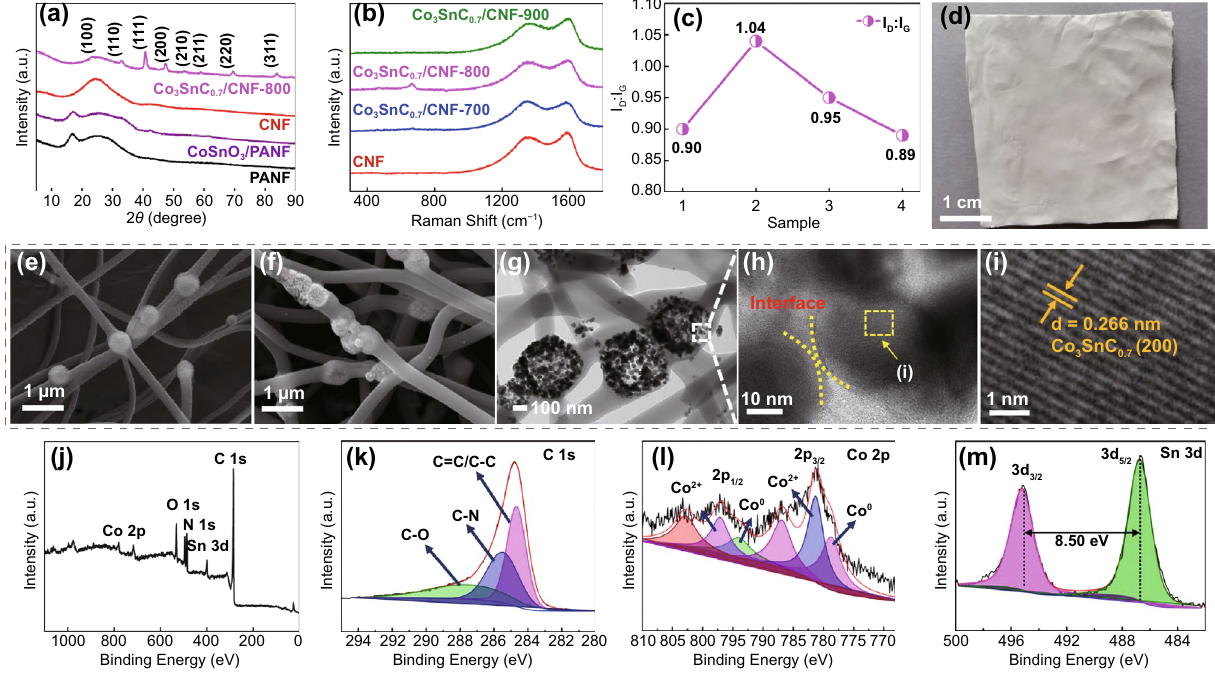
Fig. 2 The XRD pattern of PANF, CoSnO 3 /PANF, CNF, and Co 3 SnC 0.7 /CNF-800 ( a ); Raman of CNF (Sample 1) and Co 3 SnC 0.7 /CNF-700 (Sample 2), Co 3 SnC 0.7 /CNF-800 (Sample 3), and Co 3 SnC 0.7 /CNF-900 (Sample 4) ( b, c ); the digital image of CoSnO 3 /PANF ( d ); the SEM images of CoSnO 3 /PANF ( e ), Co 3 SnC 0.7 /CNF-800 ( f ); TEM: low ( g ) and high definition ( h ) of Co 3 SnC 0.7 /CNF-800; XPS spectrum of sample Co 3 SnC 0.7 /CNF-800; full spectrum ( j ); fine spectrum: C 1 s ( k ), Co 2 p ( l ), Sn 3 d ( m